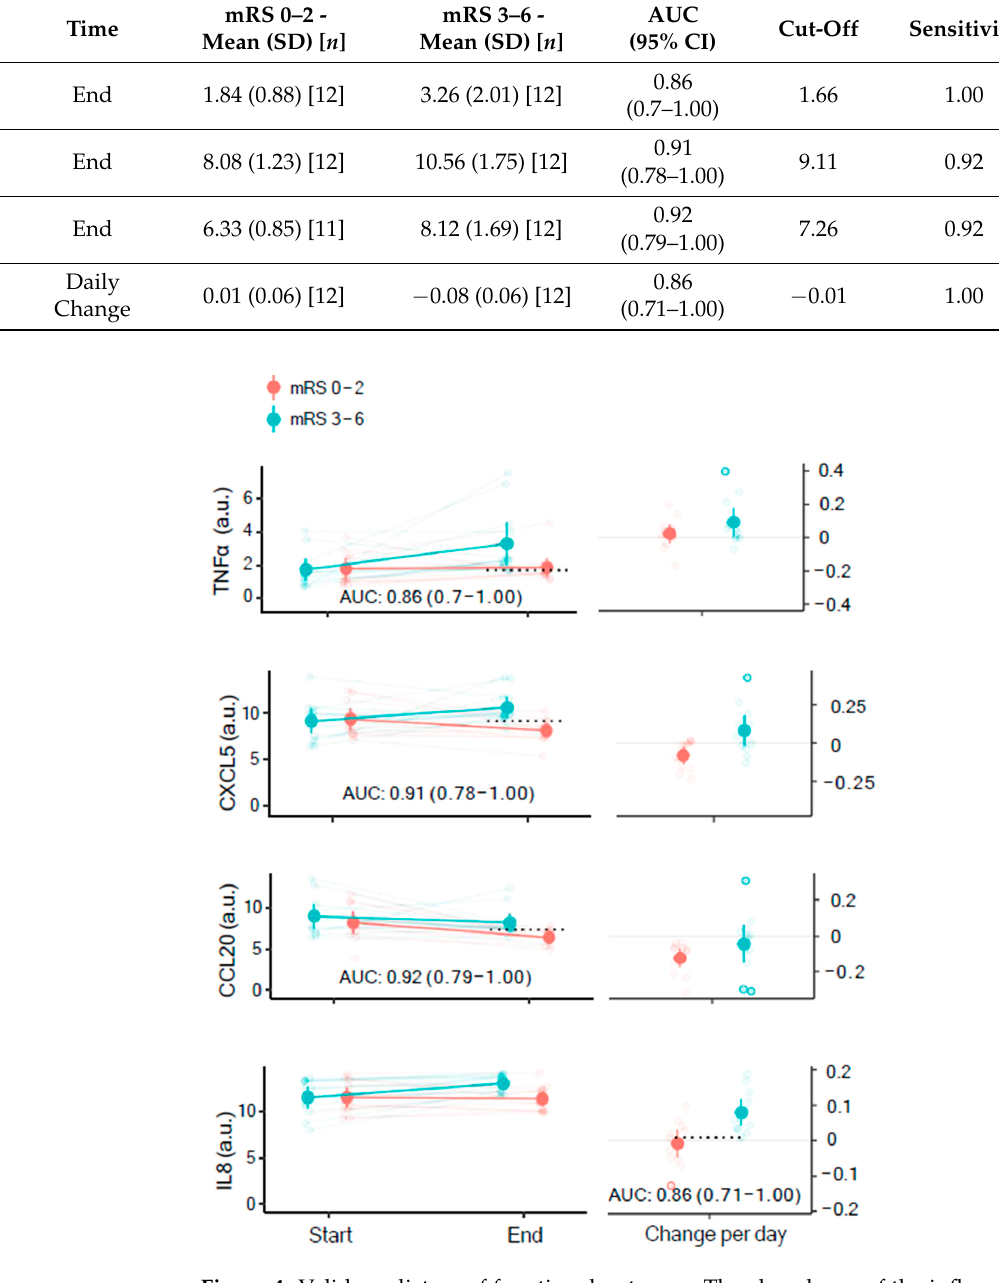
Figure 4. Valid predictors of functional outcome. The abundance of the inflammatory markers in the start vs. end sample is shown in the left column, with AUCs (AUC: arbitrary units with 95% CI), and the daily change in abundance illustrated in the right column). Dashed lines show Youden’s threshold as a cutoff for sensitivity and specificity for the given marker. Favorable functional outcome (mRS 0–2): n = 12; unfavorable functional outcome (mRS 3–6): n = 12; AUC: area under the curve; CI: confidence interval.